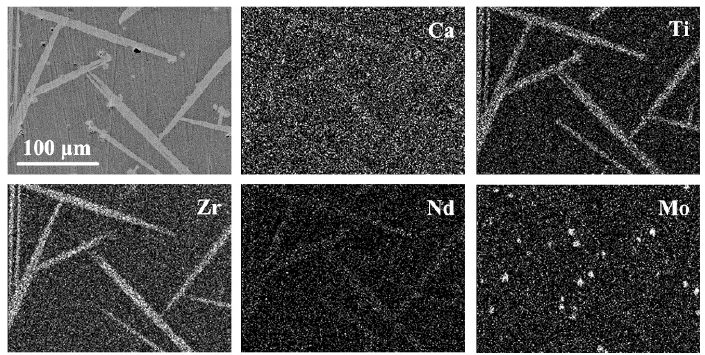
Figure 7. EDS maps of the typical CTZ-40 sample.